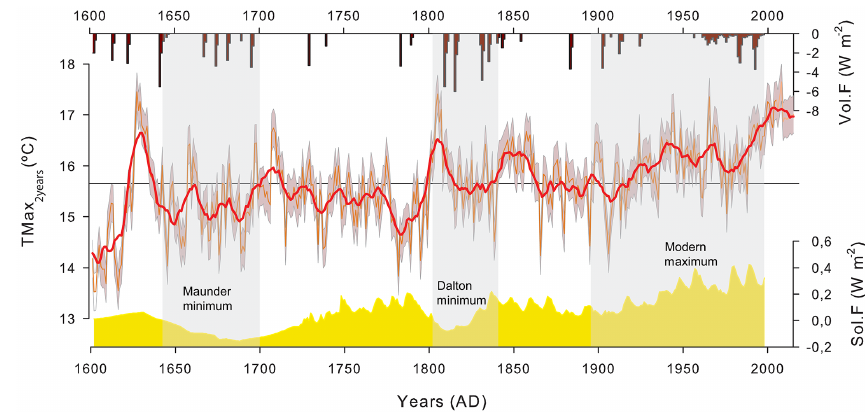
Figure 9. IR2Tmax reconstruction since AD1602 for the Iberian Range. The bold red curve is an 11-year running mean, and grey shading indicates the mean square error based on the calibration period correlation. Yellow shading at the bottom shows solar forcing and bars on top indicate volcanic forcings (Crowley, 2000).